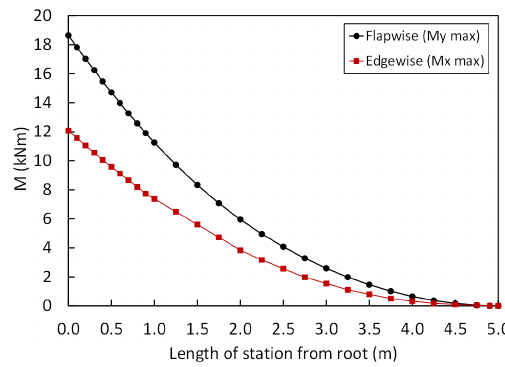
Figure 9. Extreme moment distribution along span length.